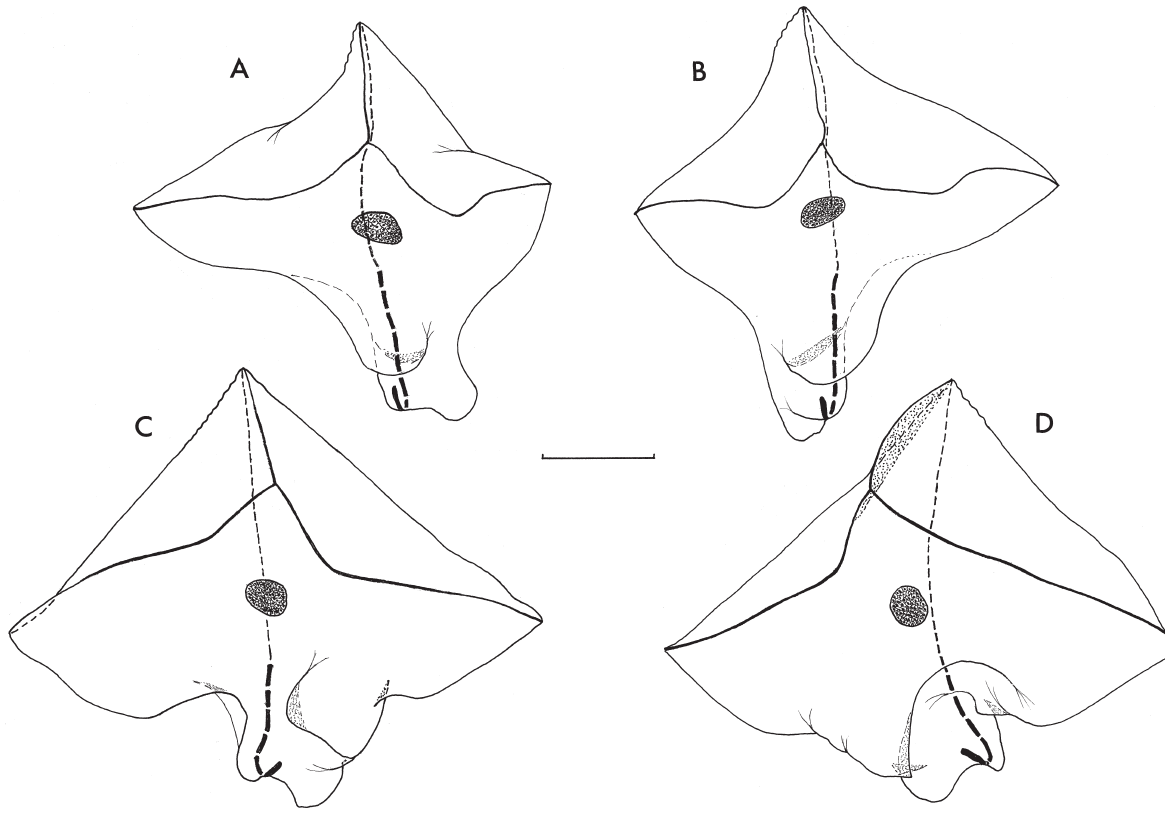
The dorsal bracts (Fig. 4a, b) measure up to c. 3.7 mm in length by 3.9 mm in width. The lateral bracts (Fig. 4c, d) are slightly larger measuring up to c. 4.0 mm in length and 4.7 mm in width. Both types of bract are roughly rhomboidal in shape. Their dorsal sides are divided into three facets by two ridges, which run straight across from the lateral corners before curving distad and uniting, forming a single ridge that runs to the distal end of the bract. The sur- faces of the two distal facets are concave. The bracteal canal runs the full length of the bract. Dis- tally it is a thin canal that runs through the mesogloea, while proximally, in the region of attachment to the stem, it is thickened and runs along the ventral surface of the bract and ultimately curves up toward the dorsal surface. There is a large patch of ectodermal cells, which are known to bio- luminesce, approximately in the middle of the dor- sal surface. The main difference between these two types of bract is that the sides of the lateral bracts are rough- ly equal in size, whereas one side is wider than